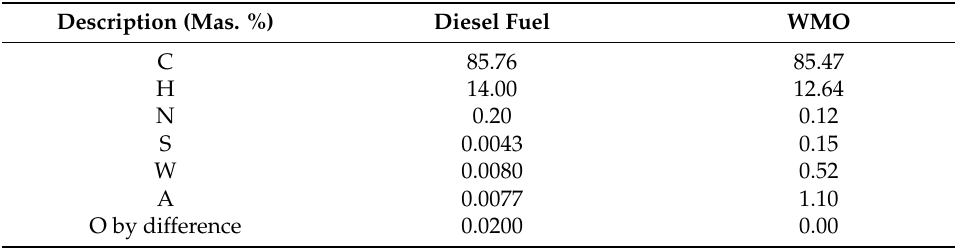
Table 1. Chemical properties of the WMO and diesel fuel [18]. Description (Mas. %)